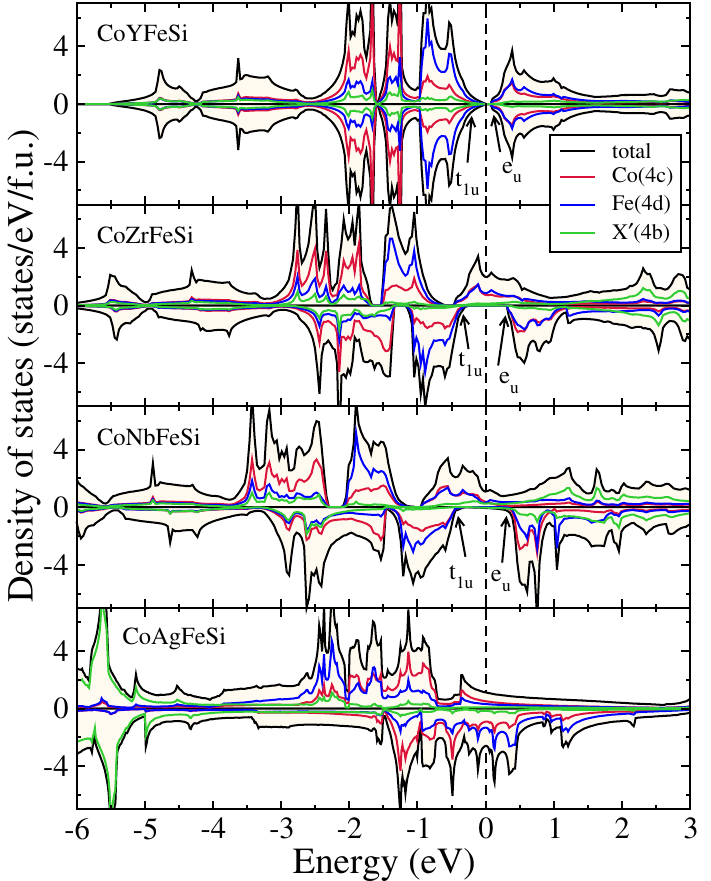
Figure 6. Spin polarized total and atom-projected densities of states for CoX ′ FeSi (X ′ = Y, Zr, Nb, Ag) alloys. The ground states of these compounds are